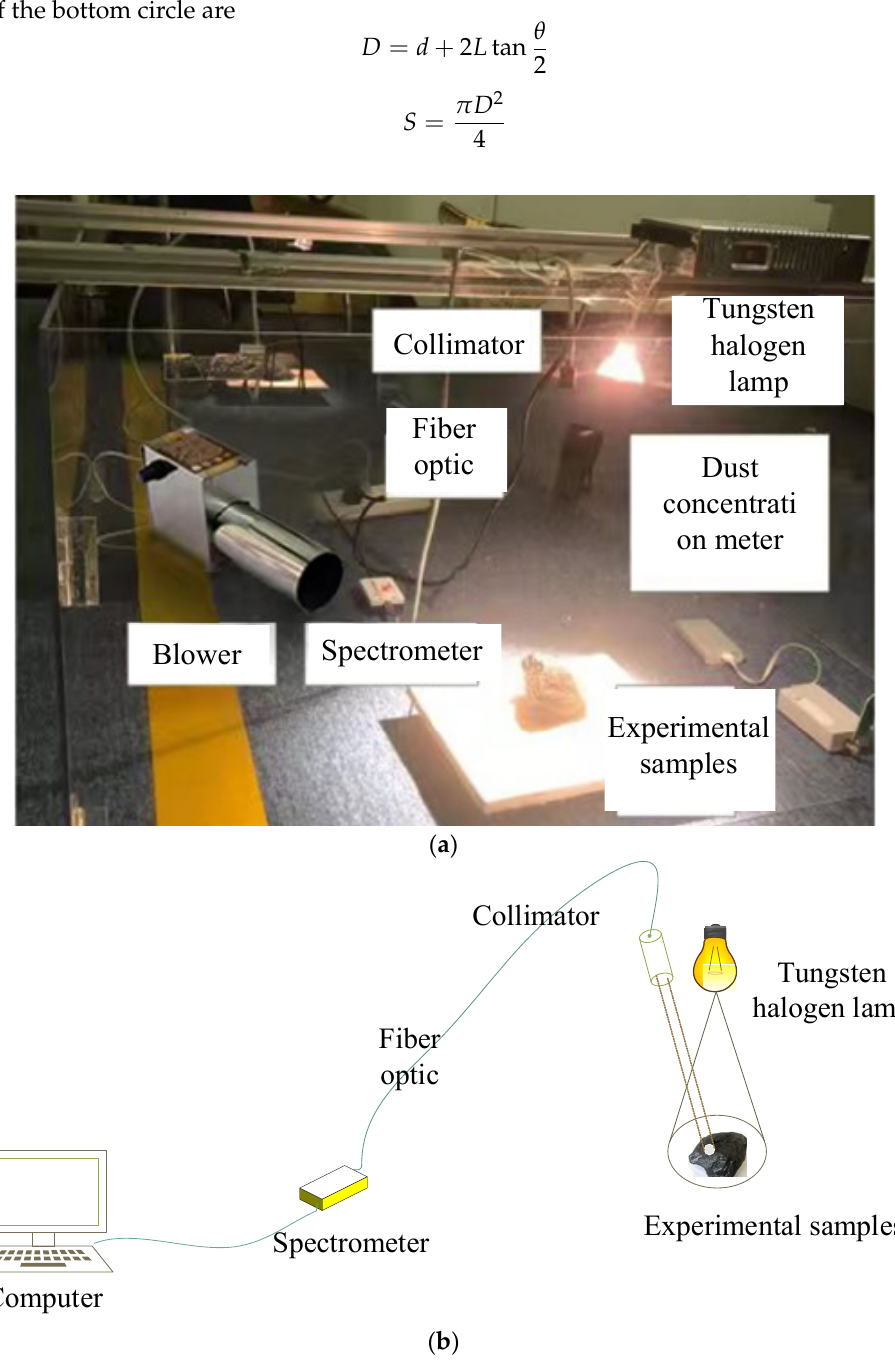
Figure 3. Gangue near-infrared reflection spectrum acquisition device. ( a ) Physical diagram, ( b ) Schematic diagram.